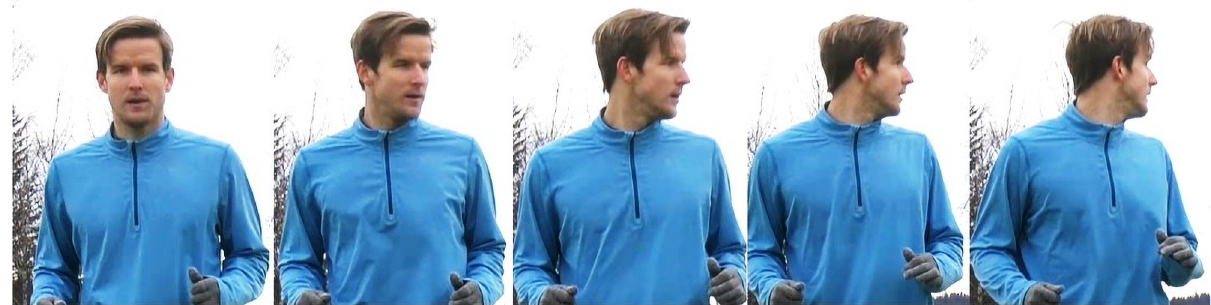
Fig 2. Illustration of a visual exploratory scan directed from the ball’s position (far left) towards information to the left of the player (far right).